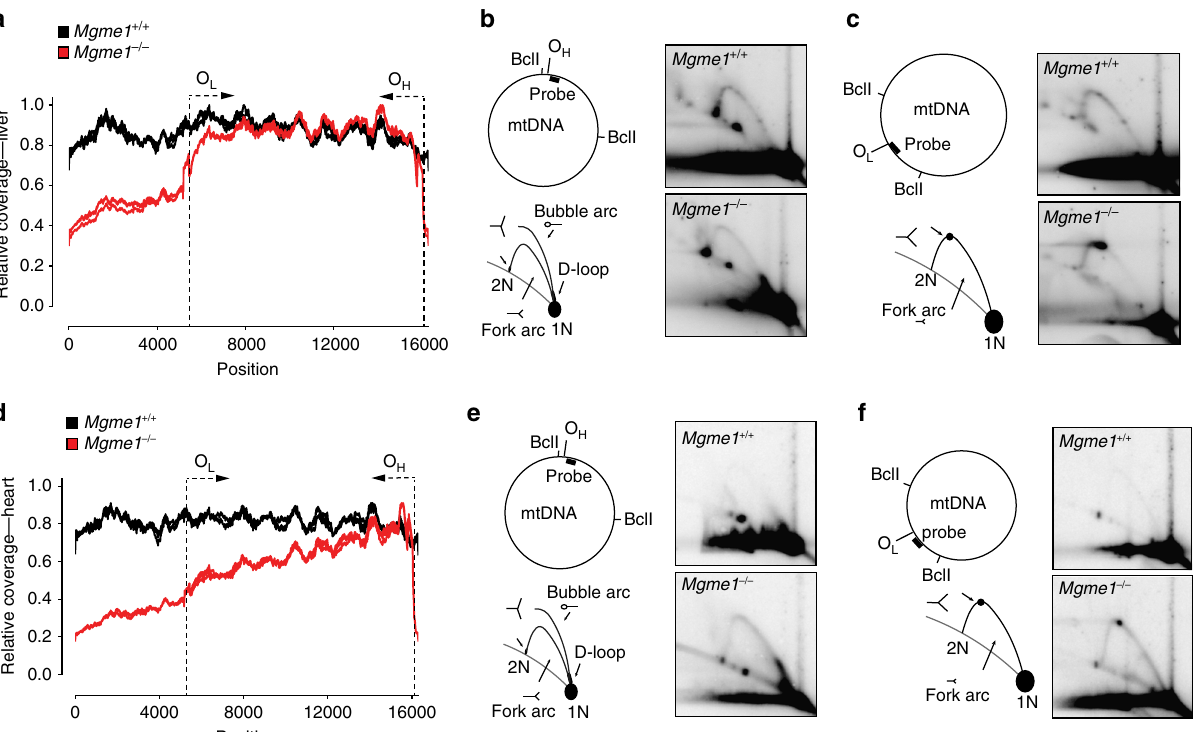
Fig. 9 Replication stalling in heart and liver of Mgme1 knockout mice visualized by next generation sequencing and 2DNAGE. a Sequence coverage of the mouse mtDNA samples from liver of Mgme1 − / − and controls. Mitochondrial genome position ( x -axis) versus sequence coverage divided by maximum coverage for each sample. For each genotype two samples derived from different mice were analyzed. The approximate locations of the origins of light- strand (O L ) and heavy-strand (O H ) replication are indicated by dotted lines with arrows. b and c mtDNA replication pattern in the liver of Mgme1 + / + and Mgme1 − / − mice analyzed by two-dimensional neutral-agarose gel electrophoresis followed by Southern blot. Restriction enzymes and probes used are indicated to the left. The black bars indicate probe used, and O H marks the origin of H-strand replication and O L denotes the origin of L-strand replication. d Same as ( a ) except that mtDNA isolated from heart tissue was used. e , f Analysis performed as in ( b ) and ( c ) but with heart samples. 1N indicates the migration of a fragment of non-replicating mtDNA, and 2N indicates the migration of fully-replicated